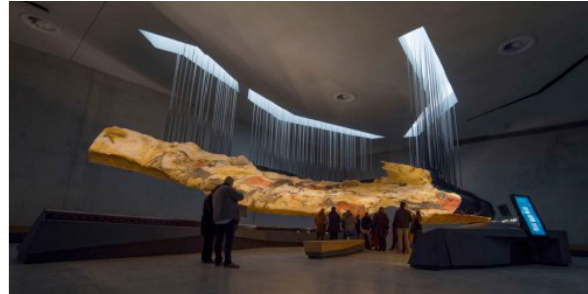
Figure 3 . View of the Lascaux IV project (https://www.lascaux.fr/fr/preparez-votre-visite/visitez- lascaux/centre-international-art-parietal).